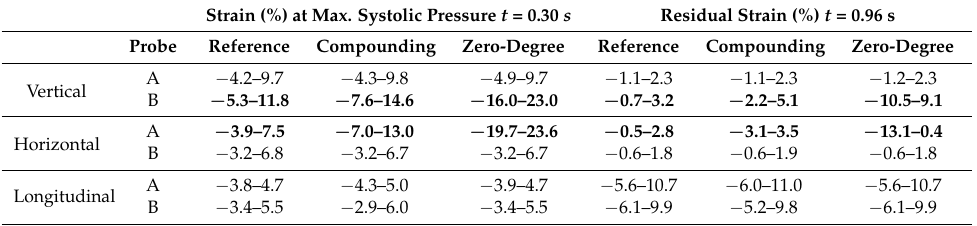
Table 3. Vertical, horizontal, and longitudinal 5th–95th percentile strain values for both probes and all